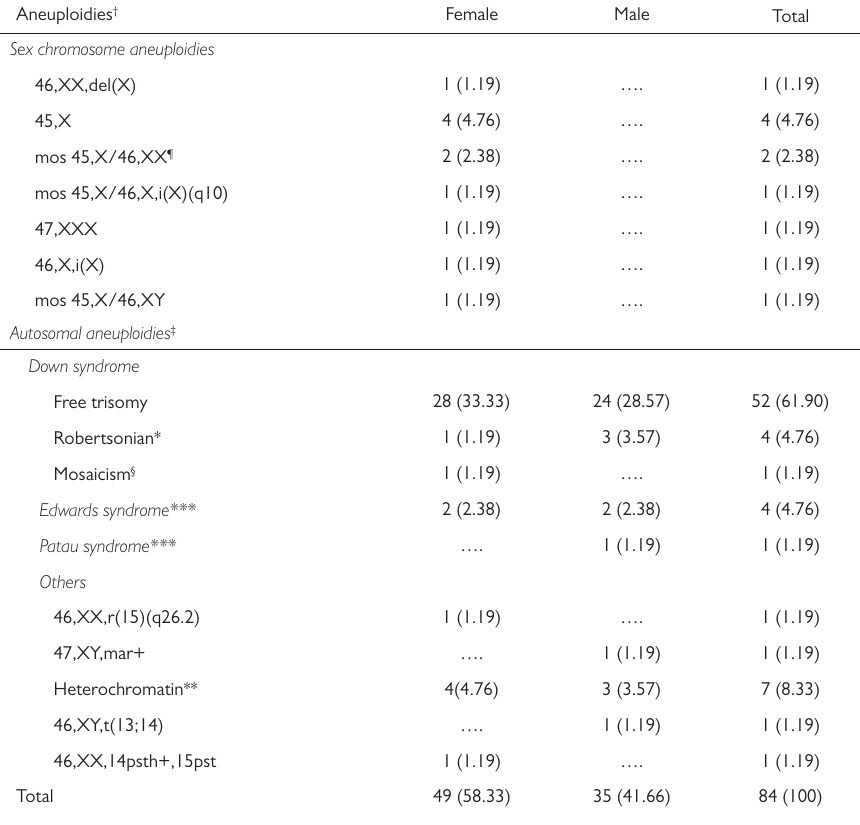
Table 1. Baseline Results of Patients with Sex Chromosome and Autosomal Aneuploidies in Lima, Peru Aneuploidies †